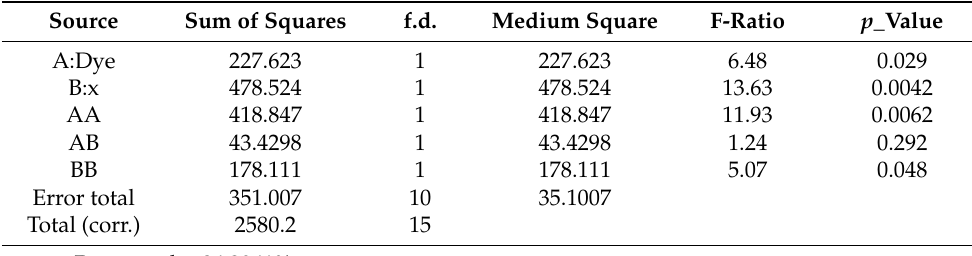
Table 4. Analisys of variance for TSR